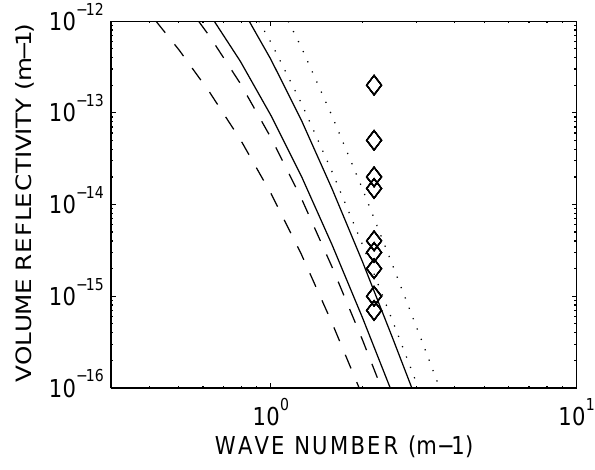
Fig. 3. PMWE volume reflectivities estimated using ESRAD ( < > ) during the MaCWAVE campaign (see text and Table 1 for details) compared with theoretical calculations for reflectivity due to neu- tral turbulence. The calculations are for 70km altitude (viscosity 0.25m 2 s − 1 ) , electron densities 1.5, 4 and 10 × 10 9 m − 3 (dotted, solid and dashed lines, respectively), electron density (1/e) scale height 4.3km, and N 2 =2 × 10 − 4 s − 2 or 6 × 10 − 4 s − 2 (N=Brunt- Vaisala frequency), turbulent energy dissipation rate 100mW/m 3